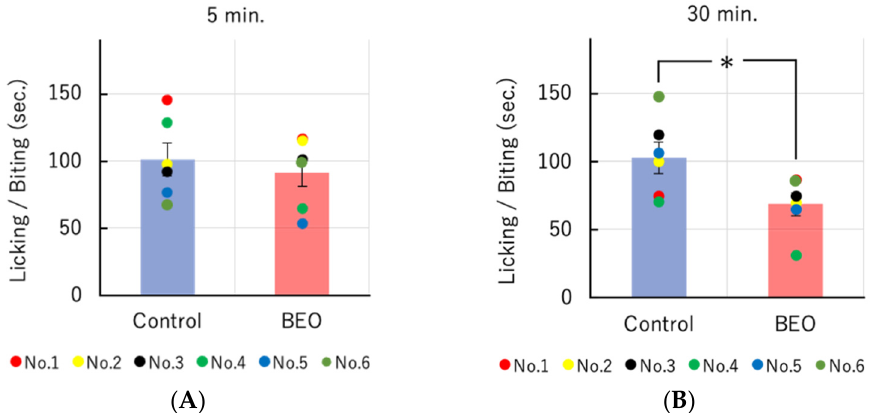
Figure 2. Effect of transdermal administration of a single therapeutic dose of NanoBEO on capsaicin- induced licking/biting behavior. ( A ) The duration of licking/biting induced by intraplantar injection of capsaicin (1.6 μ g/20 μ L) is determined using the 5-min period starting immediately after injection of capsaicin. ( B ) NanoBEO reduces significantly capsaicin-induced licking/biting behavior after 30 min. Empty cream is used as a control and it fails to affect capsaicin-induced nociceptive response. The data presented are expressed as mean ± S.E.M. ( n = 6). The value of * p < 0.05 is considered statistically